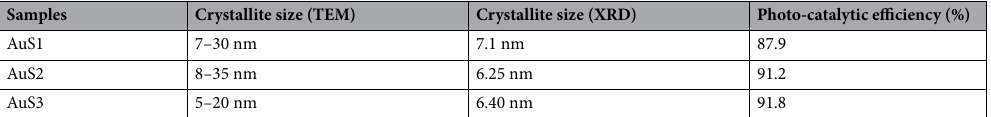
Table 3. In terms of physicochemical properties, sunlight-assisted photocatalytic performance of produced Au NPs.